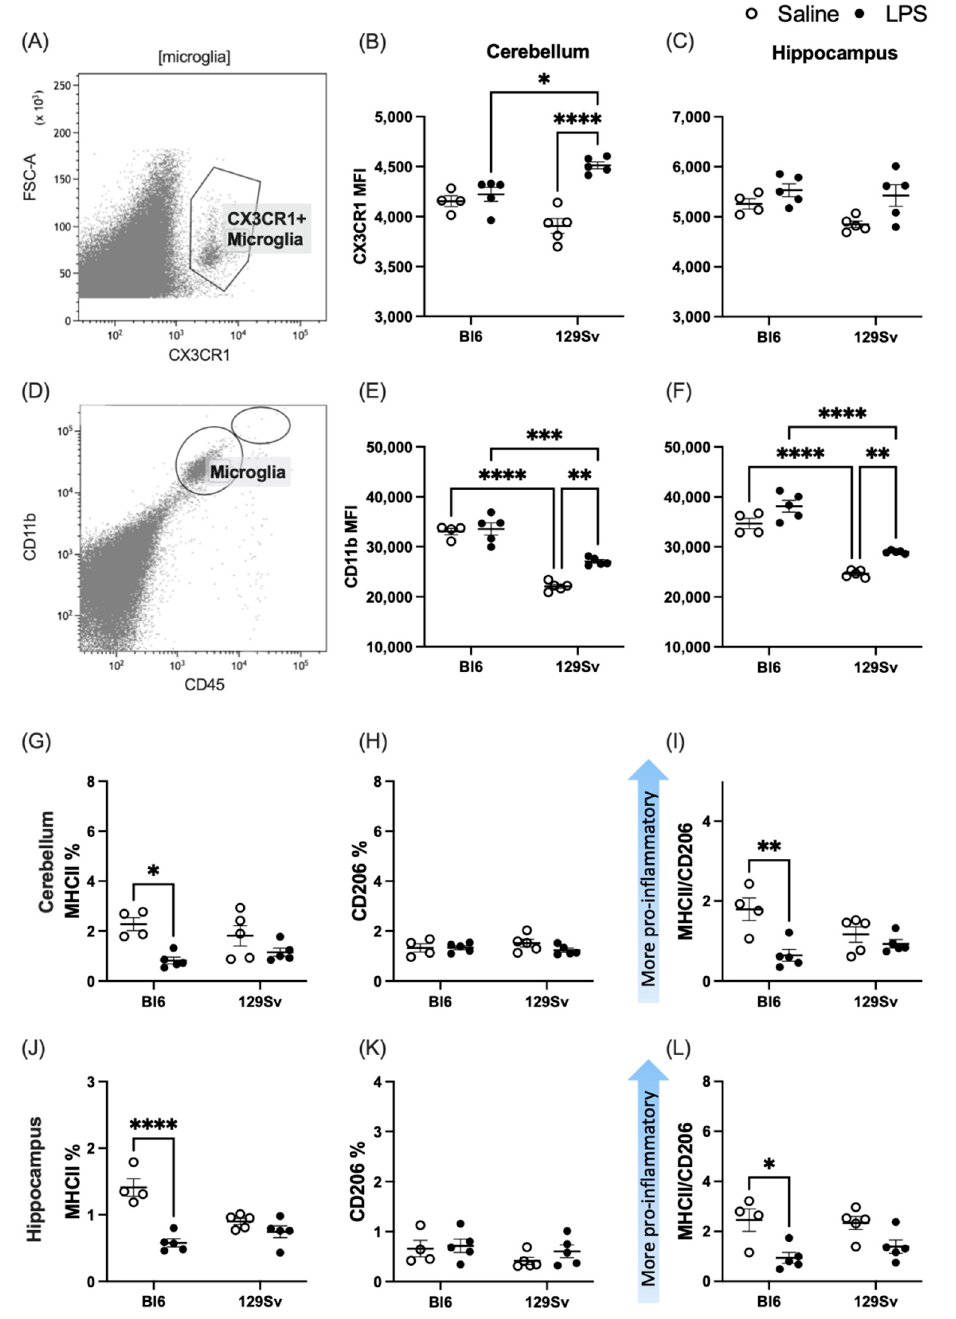
Figure 5. Microglial surface expression of CX3XR1, CD11b, MHC-II, and CD206 molecules. A rep- resentative gating strategy for CX3CR1-( A ) and CD11b-( D ) positive microglia population. MFI of CX3CR1 in cerebellum ( B ) and hippocampus ( C ). MFI of CD11b in cerebellum ( E ) and hippocam- pus ( F ). Percentages of ( G ) MHC-II and ( H ) CD206 and ( I ) ratios of MHC-II versus CD206 microglia in cerebellum. Percentages of ( J ) MHC-II and ( K ) CD206 and ( L ) ratios of MHC-II versus CD206 microglia in the hippocampus: * p ≤ 0.05, ** p ≤ 0.01, *** p ≤ 0.001, **** p ≤